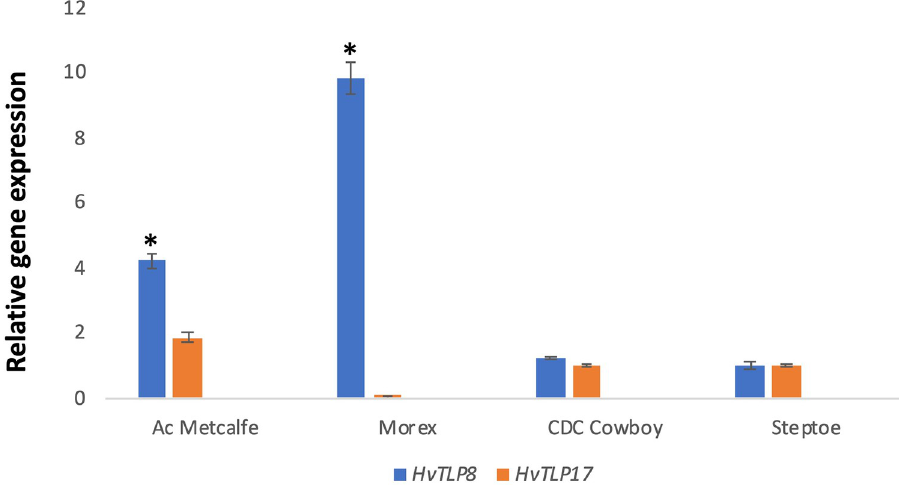
Fig 1. Expression analysis of HvTLP8 and HvTLP17 in malt (AC Metcalfe and Morex) and feed (CDC Cowboy and Steptoe) varieties at 16 hrs of grain germination. Asterisks ( * ) represent the significance of gene expression in different malt and feed varieties by measured by all pairs Tukey test at (P � 0.05).